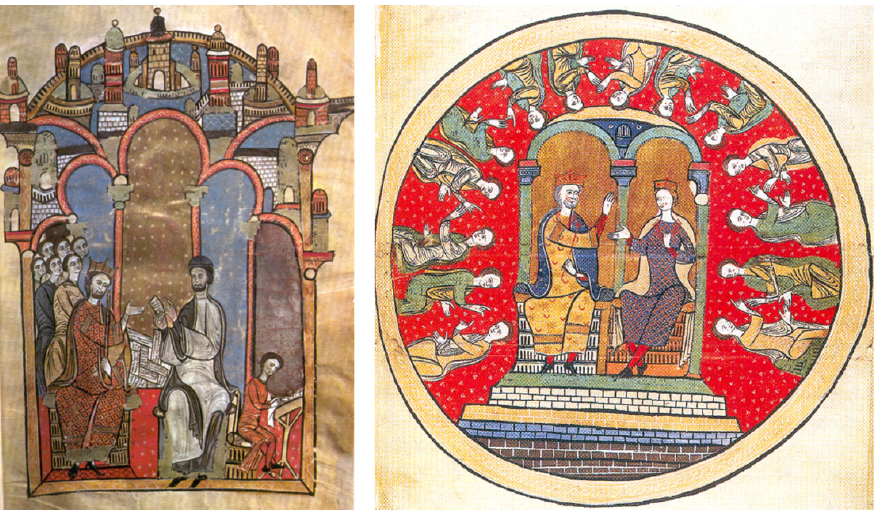
Figure 5. Liber Feudorum Maior , Canc. Reg. 1, Barcelona, Arxiu de la Corona d’Aragó ©. Fols. 1r and 1st new. Alphonse II and Alphonse II with Sancha? End of the XII Century. Published by